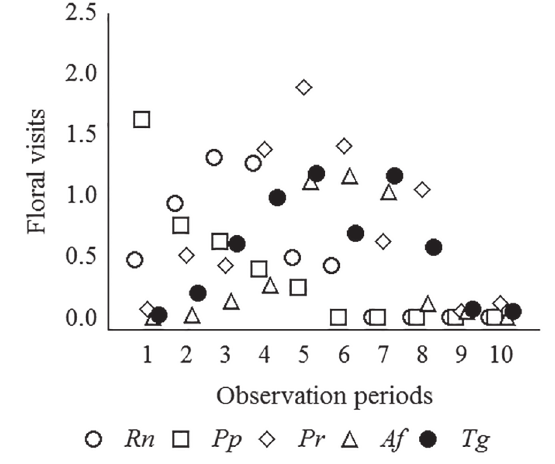
Figure 2 - Graphic results of the frequency of five hummingbird species during ten 50-minute periods of observation of flowers in 10 individuals of the plant Dahlstedtia pinnata monitored between August 2010 and August 2011, in Pedra Branca State Park, Rio de Janeiro. Rn = Ramphodon naevius , Pp = Phaethornis pretrei , Pr = P. ruber , Af = Amazilia fimbriata , Tg = Thalurania glaucopis .